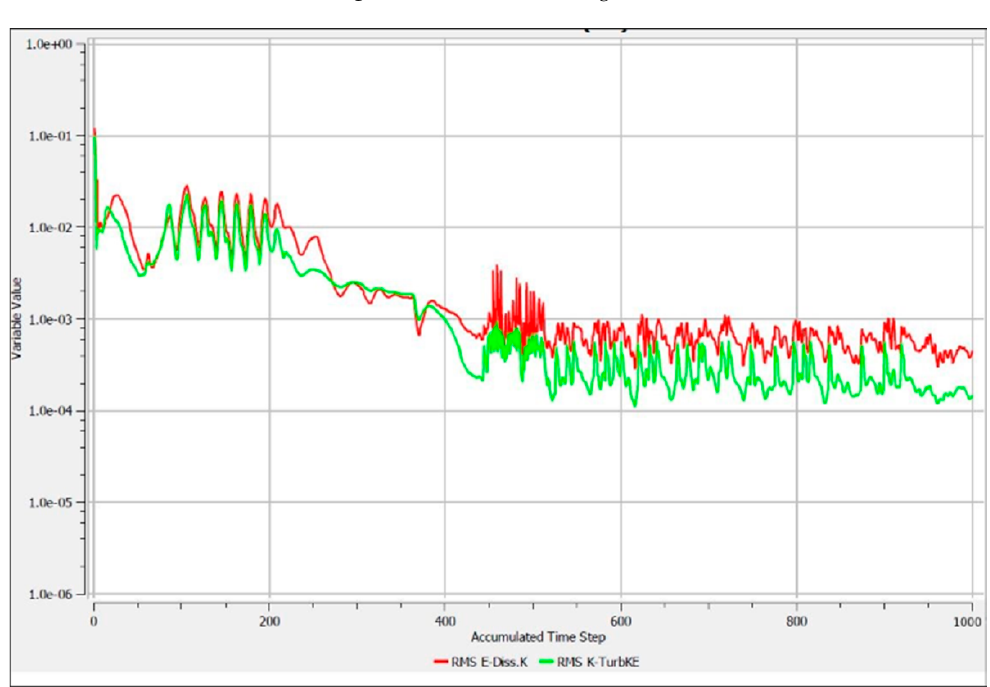
Figure 7. Turbulent convergence.